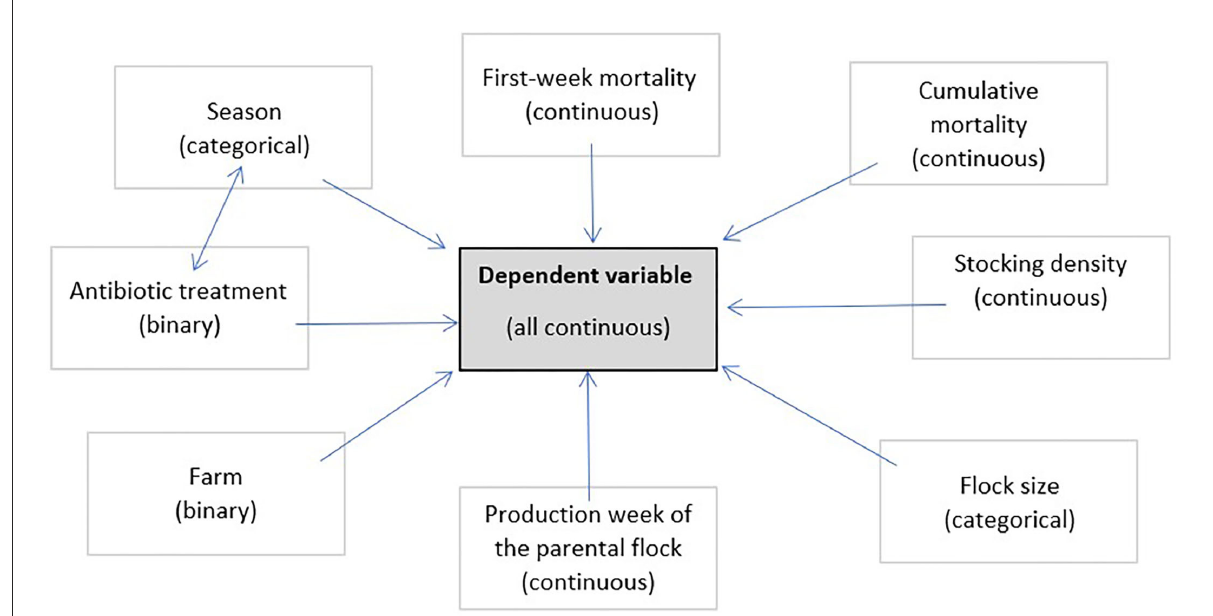
FIGURE1 Overview of the independent variables and their characteristics used in the multivariable model. First-week mortality, cumulative mortality, average weight, and the causes of condemnation (condemnation rate in total, DOA rate, deep dermatitis, ascites, not suitable for production/general disease, hepatic changes, polyserositis, underdevelopment/emaciation, other pathologic findings/hematoma/injuries, and changes in color/odor/texture) were each used as the dependent variable.